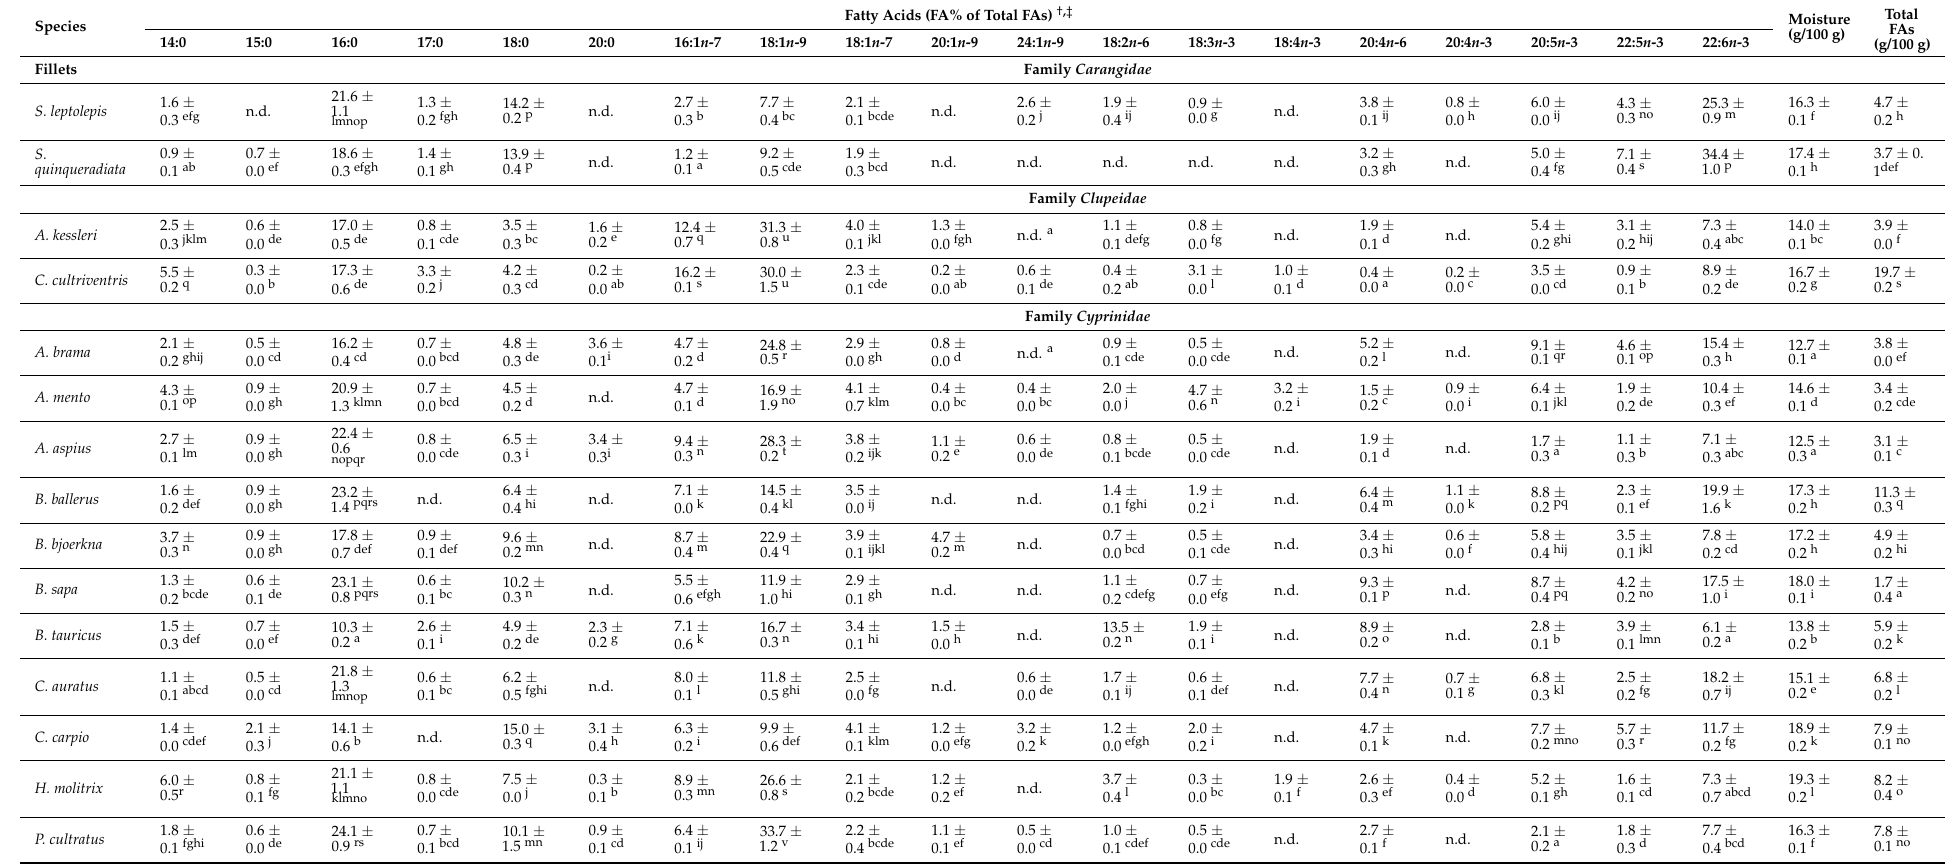
FattyAcids(FA%ofTotalFAs) † , ‡ Moisture